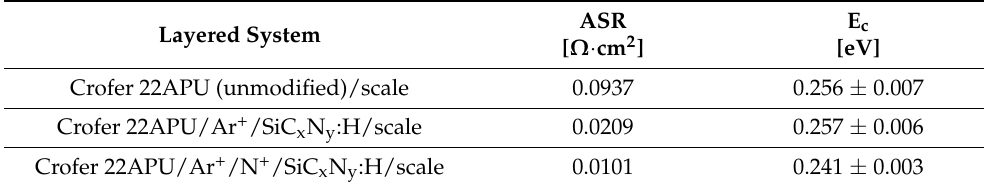
Table 7. ASR and activation energy of electrical conduction determined for the studied layered systems after 500 h of oxidation in air at 1073 K. ASR E c Layered System [ Ω · cm 2 ] [eV] Crofer 22APU (unmodified)/scale 0.0937 0.256 ± 0.007 Crofer 22APU/Ar + /SiC x N y :H/scale 0.0209 0.257 ± 0.006 Crofer 22APU/Ar + /N + /SiC x N y :H/scale 0.0101 0.241 ±